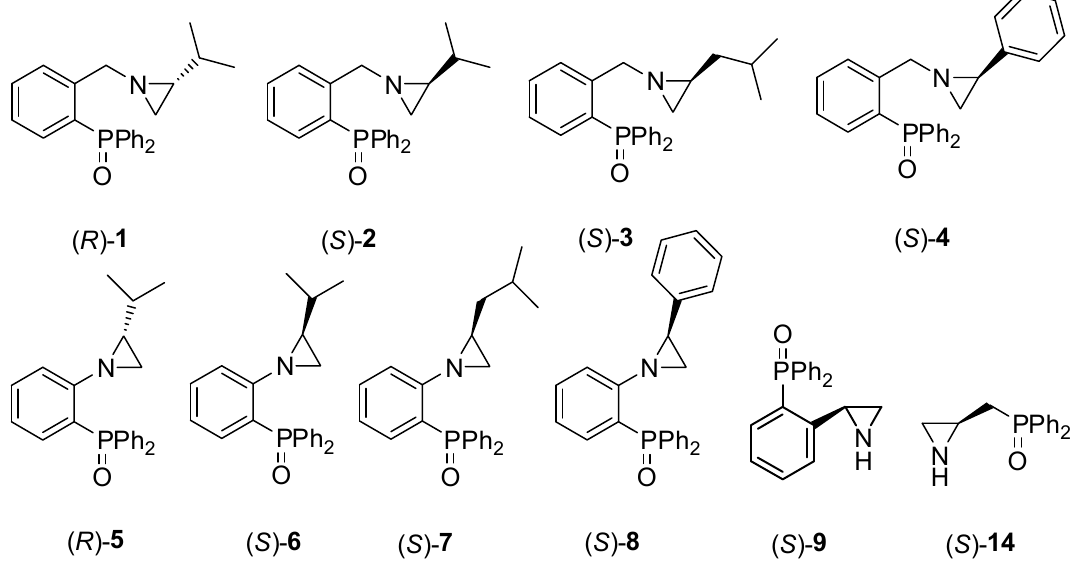
Figure 1. Chiral aziridines 1 – 9 and 14 functionalized by the P=O group.